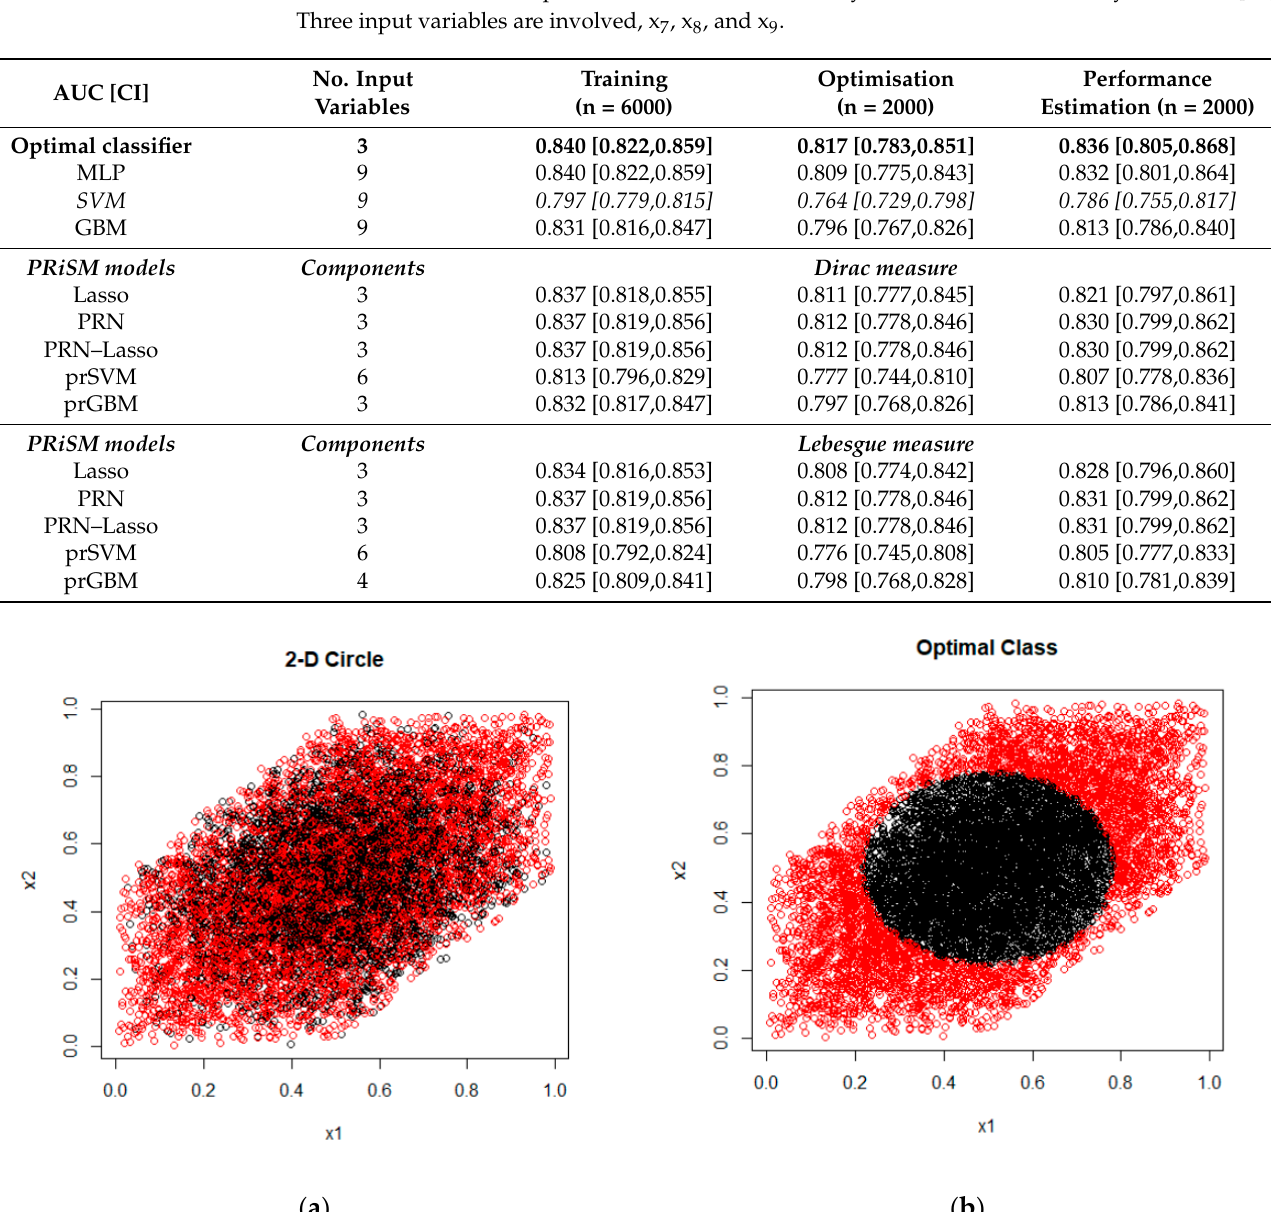
Table 4. Classification performance for the three-way interaction measured by the AUC [CI]. Three input variables are involved, x 7 , x 8 , and x 9 .